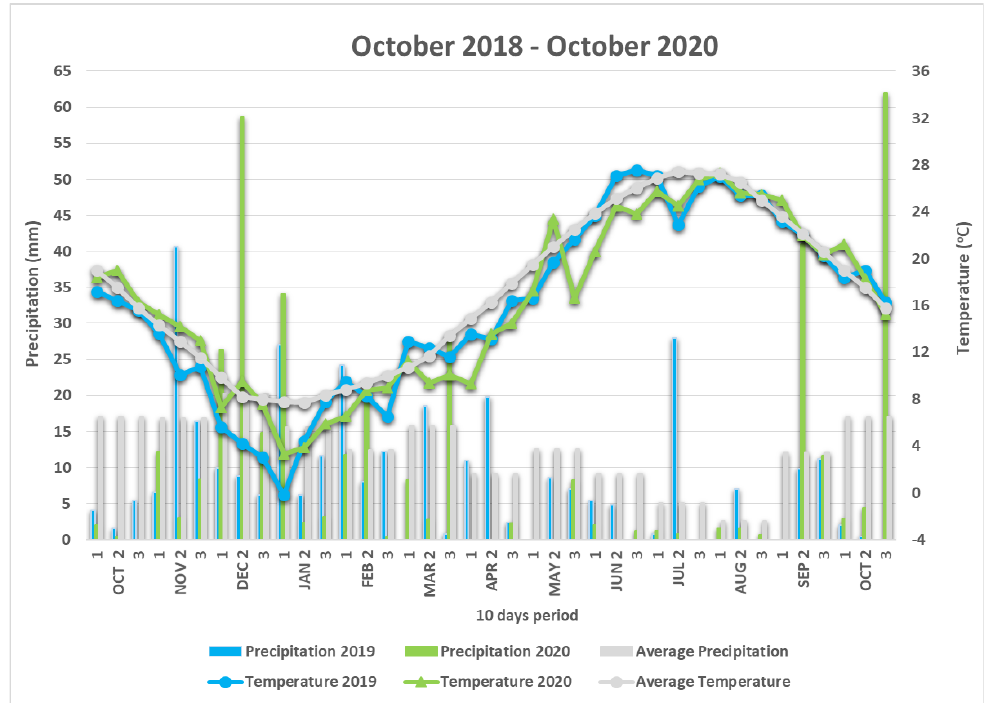
Figure 1. Average ten days air temperature-precipitation of the study site in 2019 – 2020 and average air temperature-precipitation of the last 30 years.